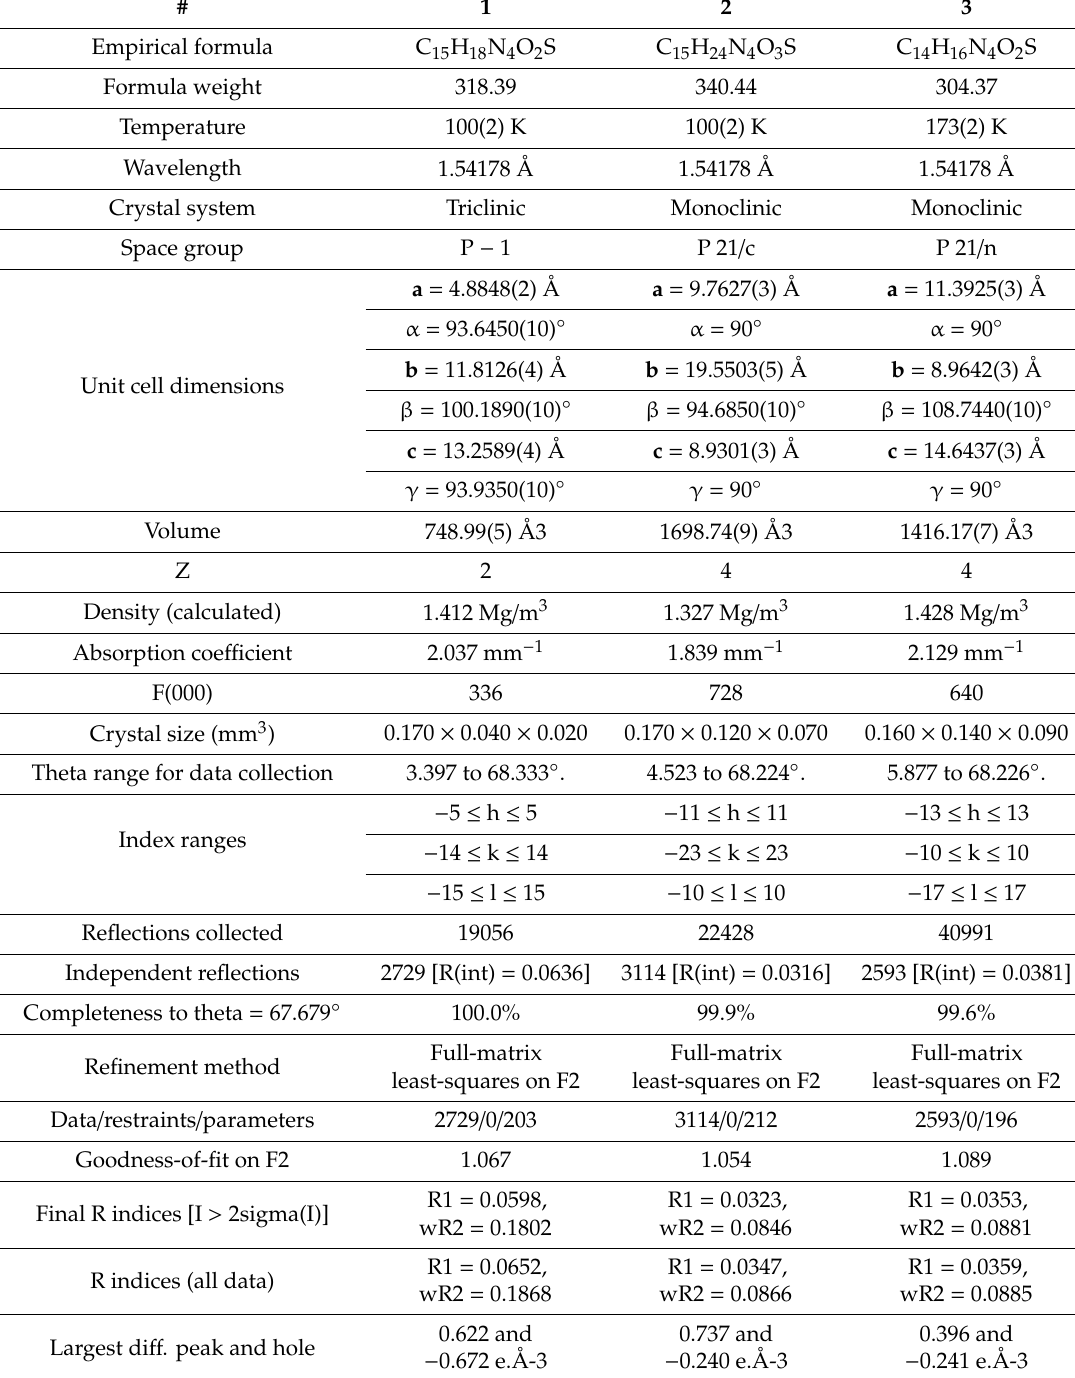
Table 1. Summary of data collection and structure refinements of crystals 1 – 3